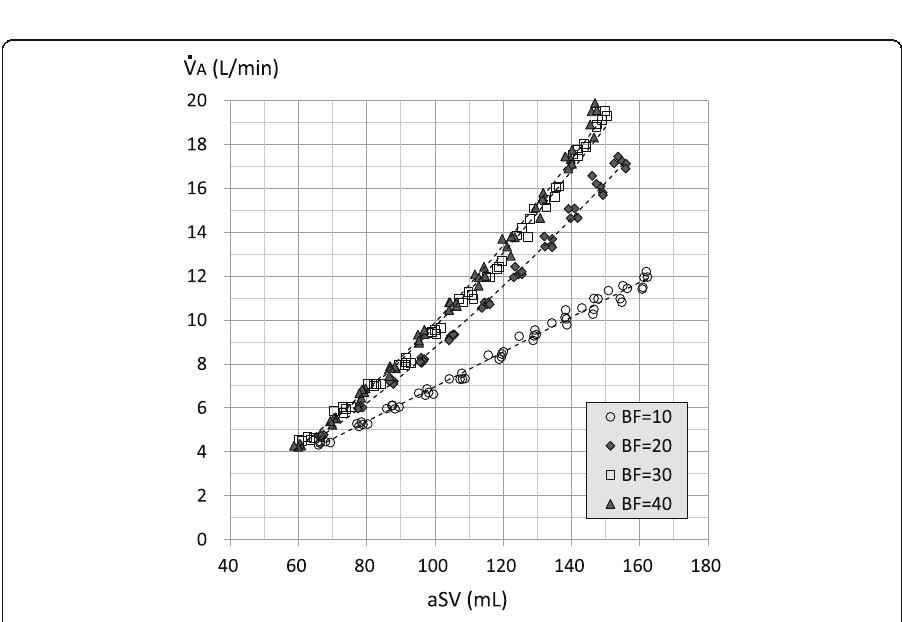
Fig. 4 Relationship between actual stroke volume (aSV) and alveolar ventilation ( _ VA). Legend: Markers indicate individual data of aSV and _ VA. Dotted curves are power approximations. The perfect powers (coefficient of correlation: R , P value) are as follows: BF=10: 1.128 ( R =0.996, P <0.001); BF=20: 1.528 ( R =0.995, P <0.001); BF=30: 1.631 ( R =0.992, P <0.001); and BF=40: 1.664 ( R =0.992, P